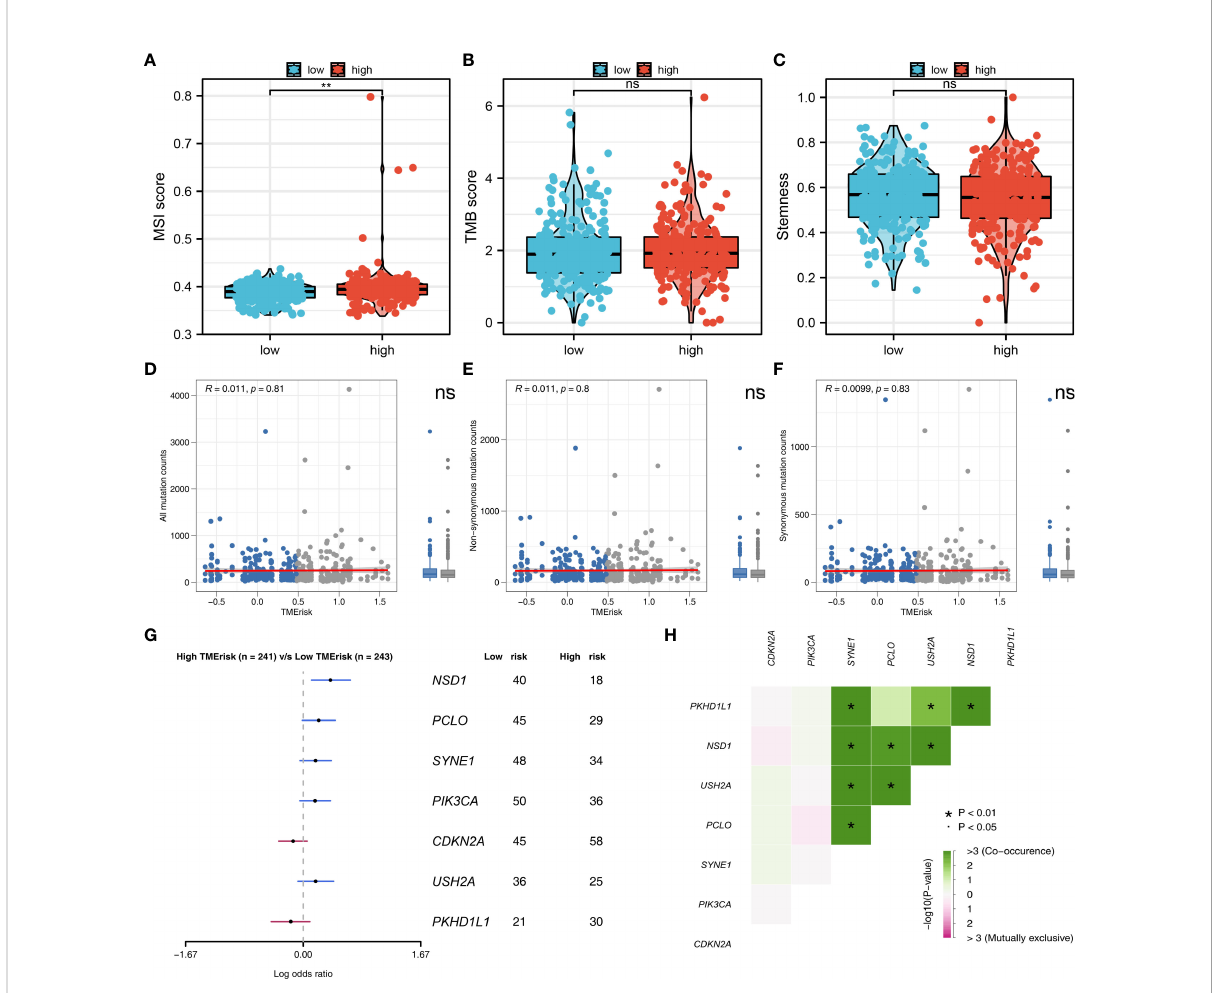
FIGURE 6 Genomic instability analysis. (A – C) The MSI, TMB and tumor stemness difference in high- and low-risk group; (D – F) The all mutation counts, non-synonymous mutation counts and synonymous mutation counts difference between high- and low-risk patients; (G) High-risk patients might be more inclined to have NSD1, PCLO, SYNE1, PIK3CA and USH2A mutated, but not CDKN2A and PKDH1L1; (H) The co-mutated correlation of these genes. **P <